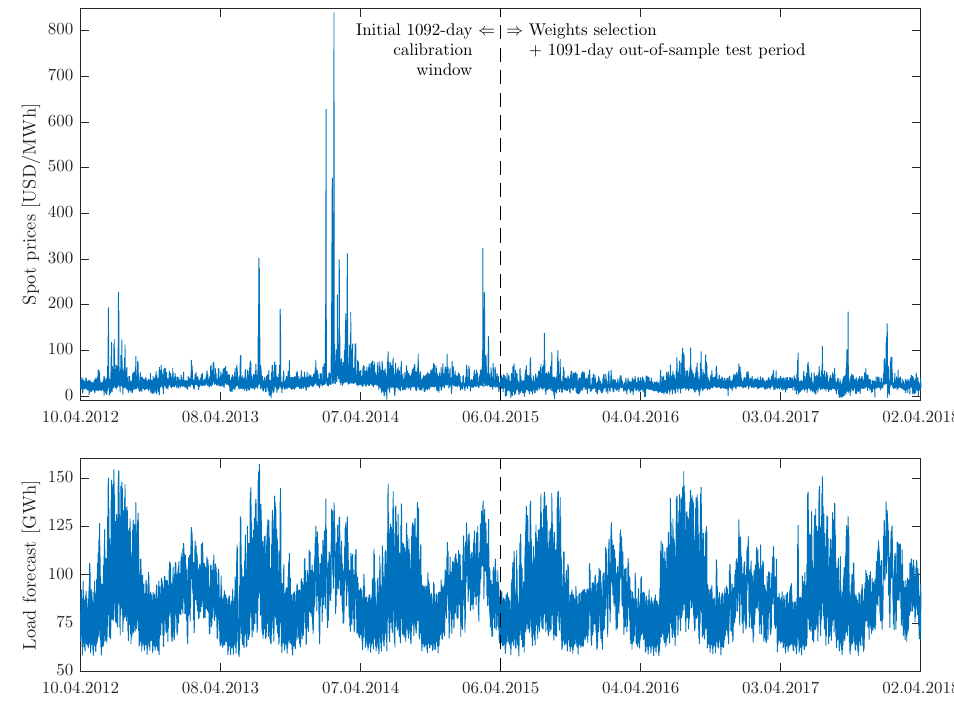
Figure 2. PJM hourly prices ( top ) and hourly consumption prognosis ( bottom ) in the Commonwealth Edison (COMED) zone from 10 April 2012 to 2 April 2018. The vertical dashed lines mark the end of the initial 1092-day calibration window (i.e., 10 April 2012–6 April 2015). Weights for the WAW approach are selected based on price predictions for the following day (i.e., 7 April 2015 for the initial calibration windows) and the remaining observations constitute the 1091-day out-of-sample test period.